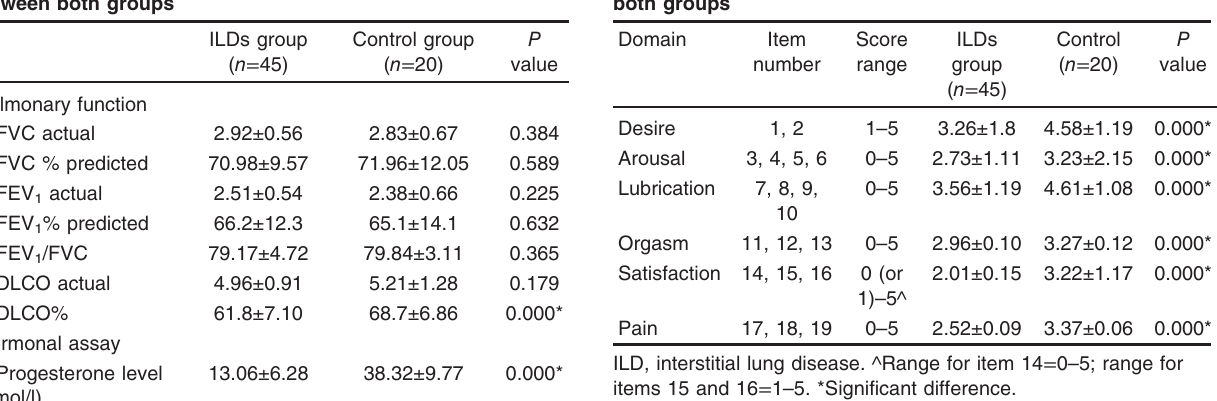
Table 2 Pulmonary function tests and hormonal assay level between both groups